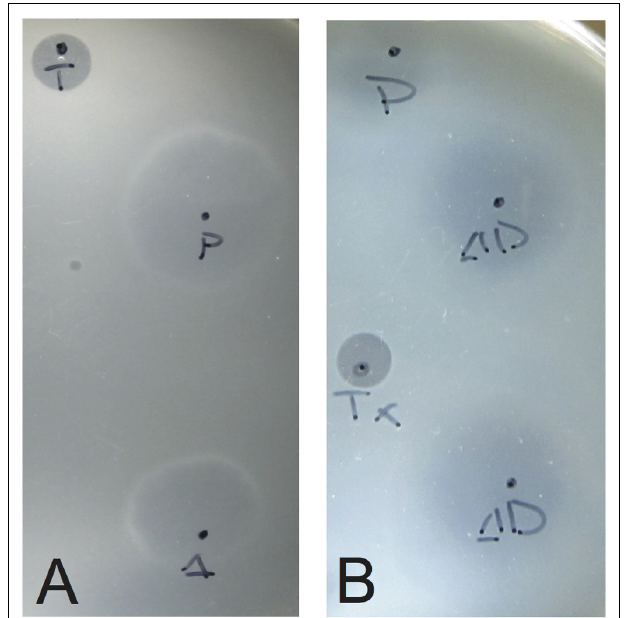
FIGURE 2 | Typical growth inhibition of S. solfataricus on plates due to infectious virus. Lawns of S. solfataricus strain G (cid:3) were prepared as in Stedman etal. (2003).Two microliters of supernatant from cultures transformed with either (A) SSV- (cid:2) VP2 or (B) SSV- (cid:2) d244 were placed on the lawns where indicated. (cid:2) indicates where SSV- (cid:2) VP2 was spotted, (cid:2) D where SSV- (cid:2) d244 was spotted. P indicates SSV-WT spotted as a positive control.T orTx indicates 2 μ L of 0.01%Triton X-100 spotted as a control for lawn